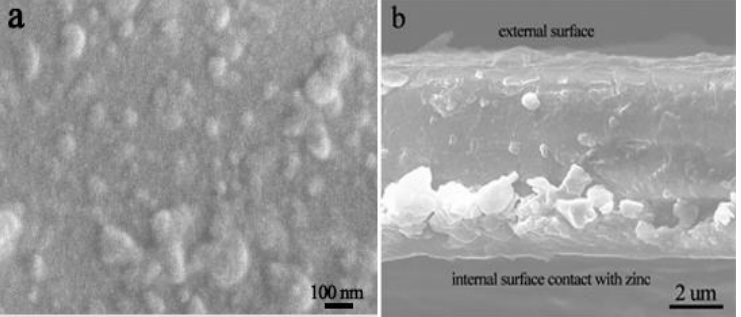
Figure 3. ( a ) Surface and ( b ) cross-section photos of the PNVPY/CB/PVP film exfoliated from coated zinc.